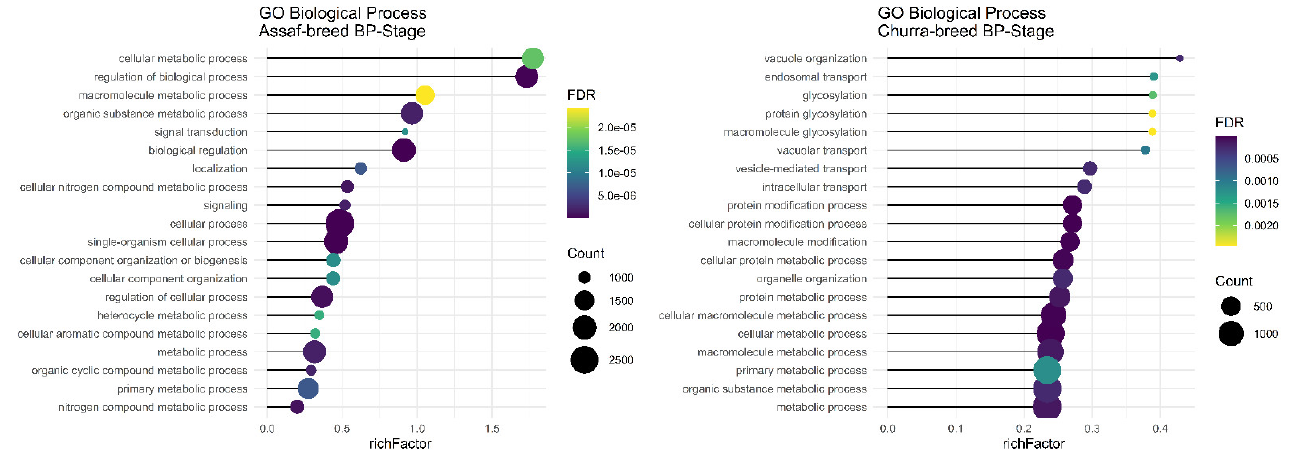
Figure 4. Functional enrichment analysis results of BP stage in Assaf and Churra sheep breeds. Since the significant biological process term is large, only 20 top significant terms are shown. The color and size of points indicate FDR and the number of genes associated with each term, respectively.